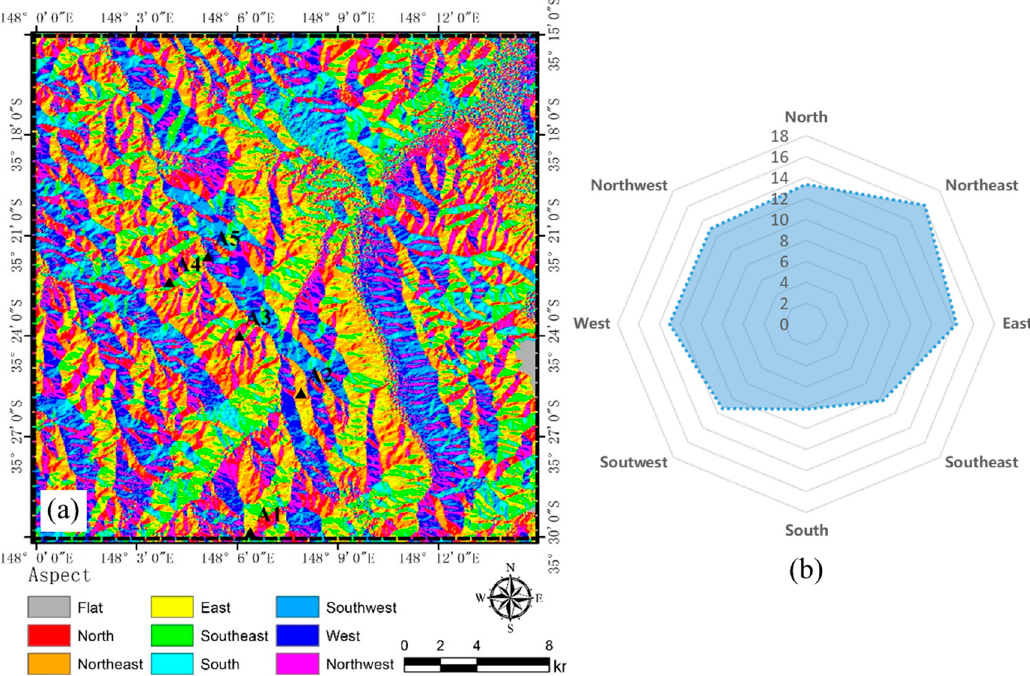
Figure 9. ( a ) Terrain aspect map derived from SRTM digital elevation model (DEM) within the pixel of 0.25° which Adelong sites are located; ( b ) statistics of the percentage of aspects at each direction within the pixel.